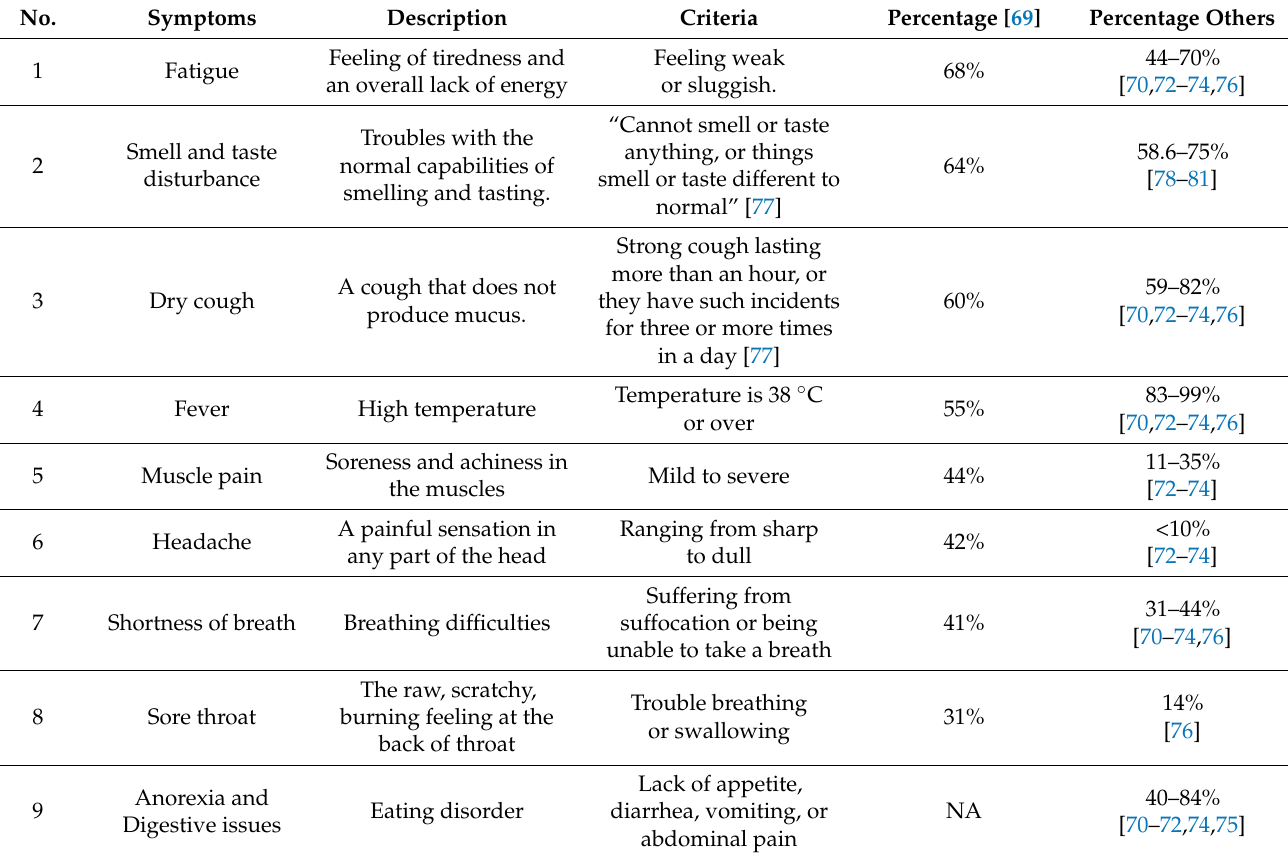
Table 3. COVID-19 symptoms